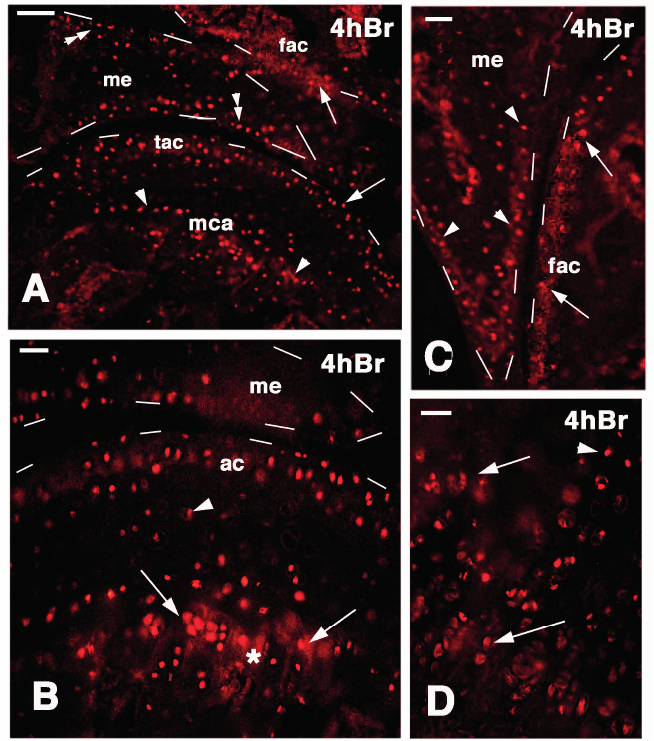
Figure 6. Immunolocalization of labeled cells in normal knee epiphyses 4 h post-injection of 5BrdU. Dashes outline the perimetry of the epiphesis and meniscus. ( A ) The main distribution of labeled cells is observed along the surface of the articular cartilages (arrows), in the metaphyseal plate (arrowheads), and along the meniscus surface (double arrowheads). Bar, 50 µm; ( B ) Detail on labeled cells in the more superficial part of the articular cartilage, and in the serial cartilage of the metaphyseal plate (arrows, the asterisk indicates a non-specific fluorescence around cells due to fluorofore absorption in the mineralizing matrix). Sparse labeled cells are seen in the intermediate region (arrowhead). Bar, 25 µm; ( C ) Other detail showing labeled cells in the femur articular cartilage (arrows) and meniscus (arrowheads). Bar, 25 µm; ( D ) Detail on the labeled cells within the serial cartilage (proliferating region) of the metaphyseal plate and germinal area (arrowhead). Bar, 25 µm. Legends : fac, femur articular cartilage; me, meniscus; mca, metaphyseal cartilage; tac, tibia articular